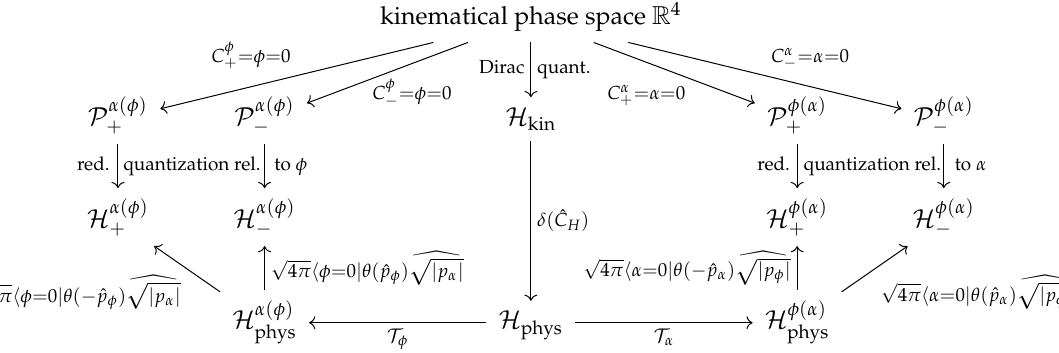
Figure 2. Diagrammatic overview of the relation between Dirac and the four reduced quantizations. In a nutshell, the physical Hilbert space is mapped to any of the four (positive or negative frequency) reduced Hilbert spaces by first trivializing the Hamiltonian constraint via T φ or T α to the corresponding choice of internal time variable and subsequently projecting onto the classical internal time gauge-fixing condition. (Details in the main